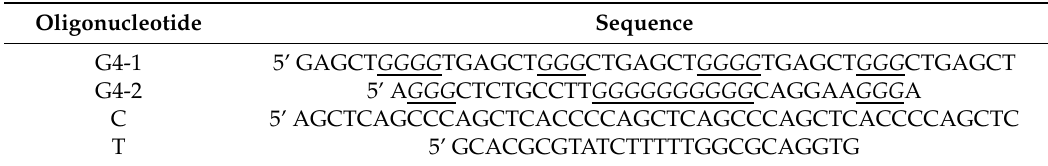
Table 1. The sequences of the oligonucleotides used in pull down assay. Guanine runs are underlined and